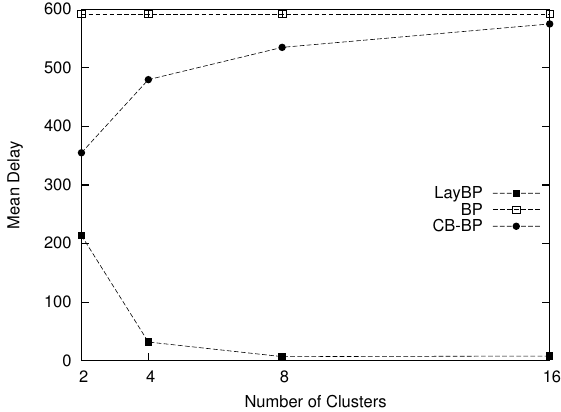
Figure 6. Impact of the number of clusters on the grid network